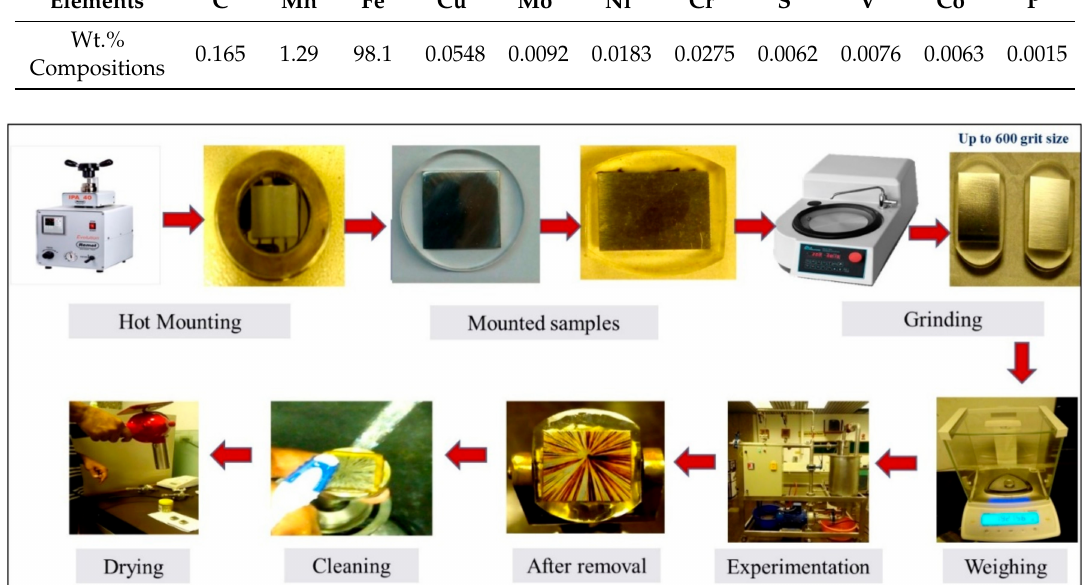
Figure 2. Specimen preparation process showing all the steps involved from the start till